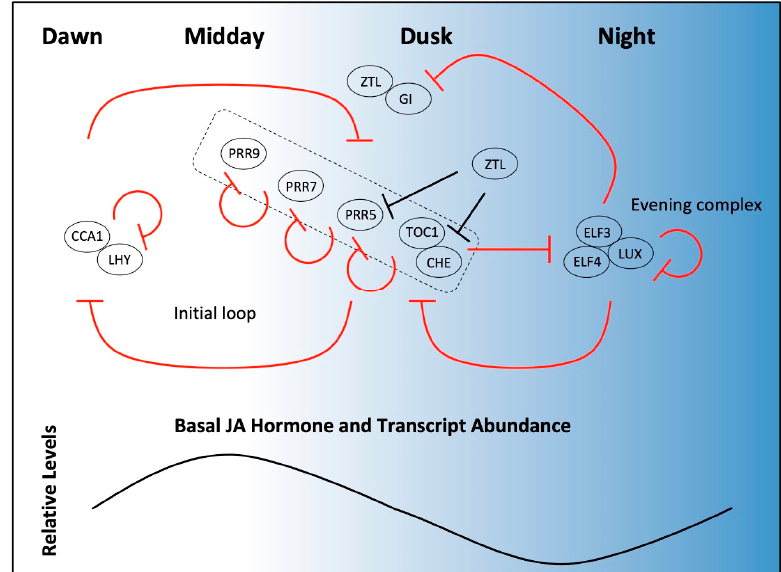
Figure 1. Progression of a simplified oscillator and JA processes over the 24-h day. Core oscillator components that are directly relevant to JA processes are shown (top) where proteins (ovals) appear at the time of their peak activity between dawn (left) and night (right). Transcriptional regulation events are depicted by red lines and post-translational regulation events are shown with black lines. The clock proteins shown at each phase, in general, suppress activities at other parts of the day. Morning proteins (CCA1 / LHY) repress PRR genes, including TOC1 , and themselves. PRR activity (grouped in box) is sequential throughout the day; PRRs repress previous PRR genes and CCA1 / LHY . The evening complex (EC) represses TOC1 , GI , and itself. F-box protein ZTL is stabilized by GI in blue light, but targets (without GI) PRR5, TOC1, and CHE for ubiquitylation and degradation in the dark. Proteins depicted here are relevant to the discussion of JA processes; other clock proteins exist with both repression and activation roles. JA biosynthesis genes, JA levels, and many JA response genes cycle over the course of 24 h and thus time many aspects of JA action to midday (bottom).